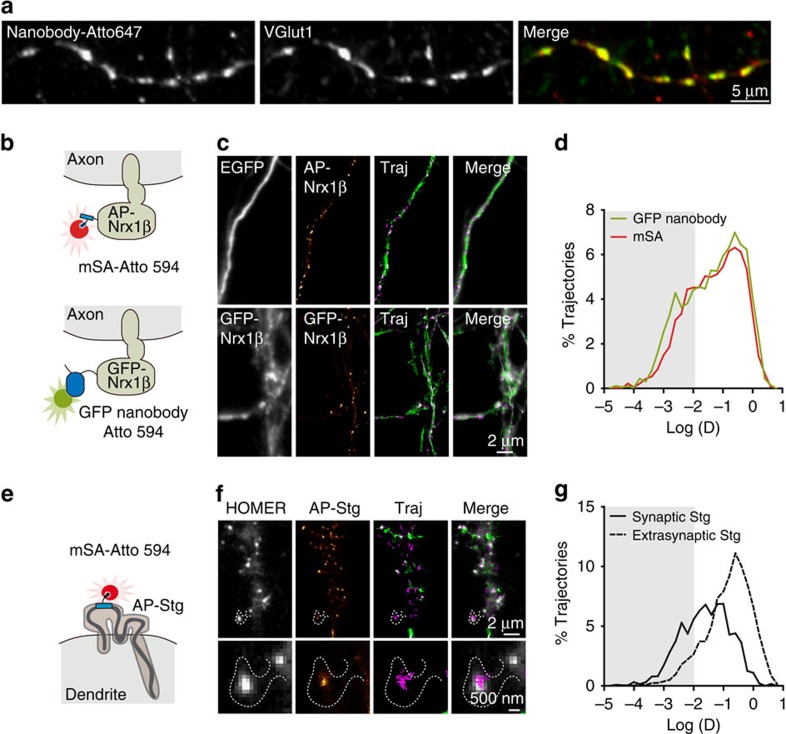
Comparison of mSA and GFP nanobody.(a) DIV 15 axons expressing GFP-Nrx1β were live-labelled using anti-GFP nanobody-Atto647, followed by immunolabelling for VGlut1 to stain pre-synaptic glutamatergic terminals. The merged image shows the colocalization between GFP-Nrx1β (red) and VGlut1 (green). (b) Schematics showing the labelling of AP-Nrx1β with mSA-Atto594 (top) and GFP-Nrx1β with GFP nanobody-Atto594 (bottom). (c) Examples of axonal regions from DIV 15 neurons expressing EGFP, AP-Nrx1β and BirAER (top); or GFP-Nrx1β (bottom). From left to right: GFP signal, Nrx1 β detection maps, colour-coded Nrx1β trajectory maps (green: fast-diffusing pool, that is, D>0.01 μm2 s−1; magenta: slow diffusing pool, that is, D<0.01 μm2 s−1), merged image showing Nrx1β trajectories overlaid with GFP (grey). (d) Distributions of the diffusion coefficients obtained for AP-Nrx1β or GFP-Nrx1β (mSA, n=6; GFP nanobody, n=5 cells from two different experiments). (e) Schematics showing the structure of the AMPA receptor auxiliary protein stargazin (Stg) with the insertion of an AP tag in the first extracellular protein loop. (f) Example of DIV 15 neurons co-expressing the synaptic marker Homer1c-GFP, AP-Stg and BirAER. AP-Stg individual molecules were tracked using mSA-Atto594 by uPAINT. Super-resolved AP-Stg localization and trajectory maps were reconstructed from 4,000 images of 20-ms exposure time, with the same colour code as in b. (g) Diffusion coefficient distribution of AP-Stg inside and outside synapses (n=6 cells from two different experiments).